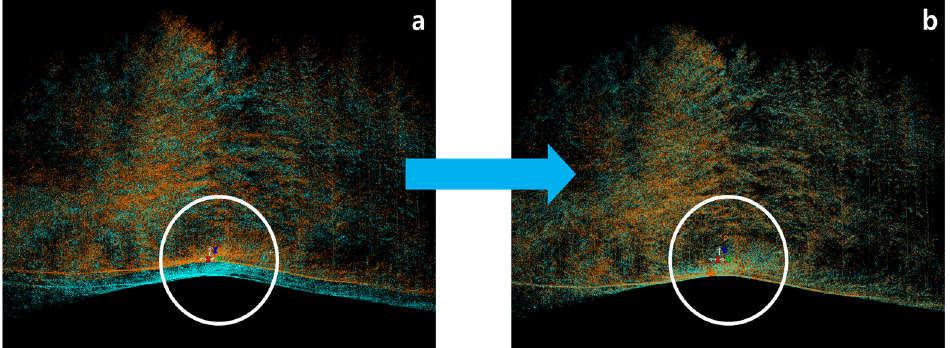
Figure 5. Description of the co-registration procedure using the software, Cyclone REGISTER 360. ( a ) before co-registration and ( b ) after co-registration. Data collected from different scan spots were co-registered and integrated (Figure